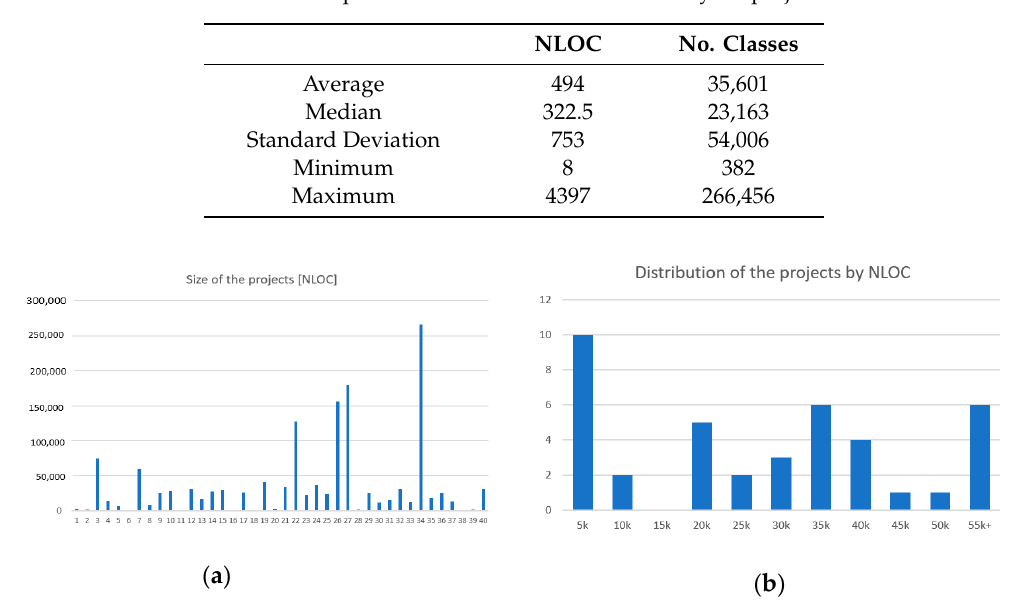
Figure 2. ( a ) The sizes of the projects in NLOC, where project IDs from Appendix A are on the x-axis. ( b ) The distribution of projects by size.